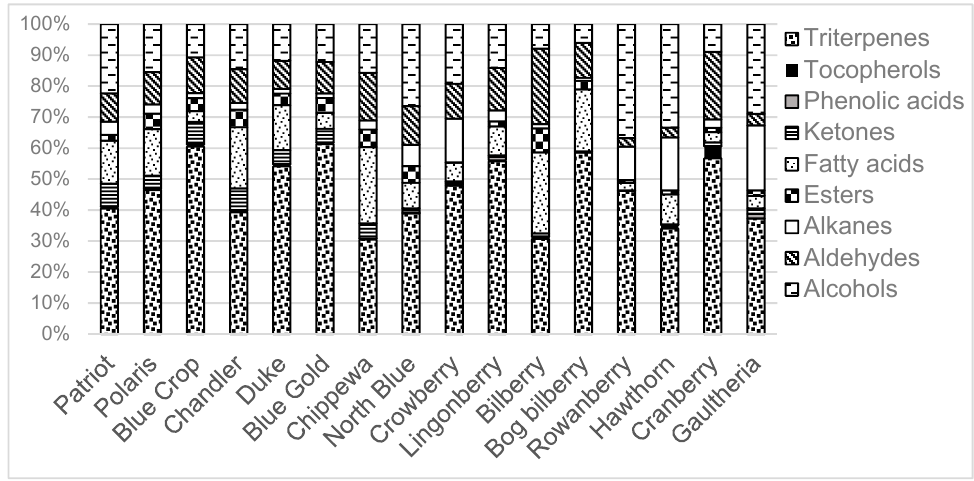
Figure 1. Relative amounts of identified compound classes in studied berries.